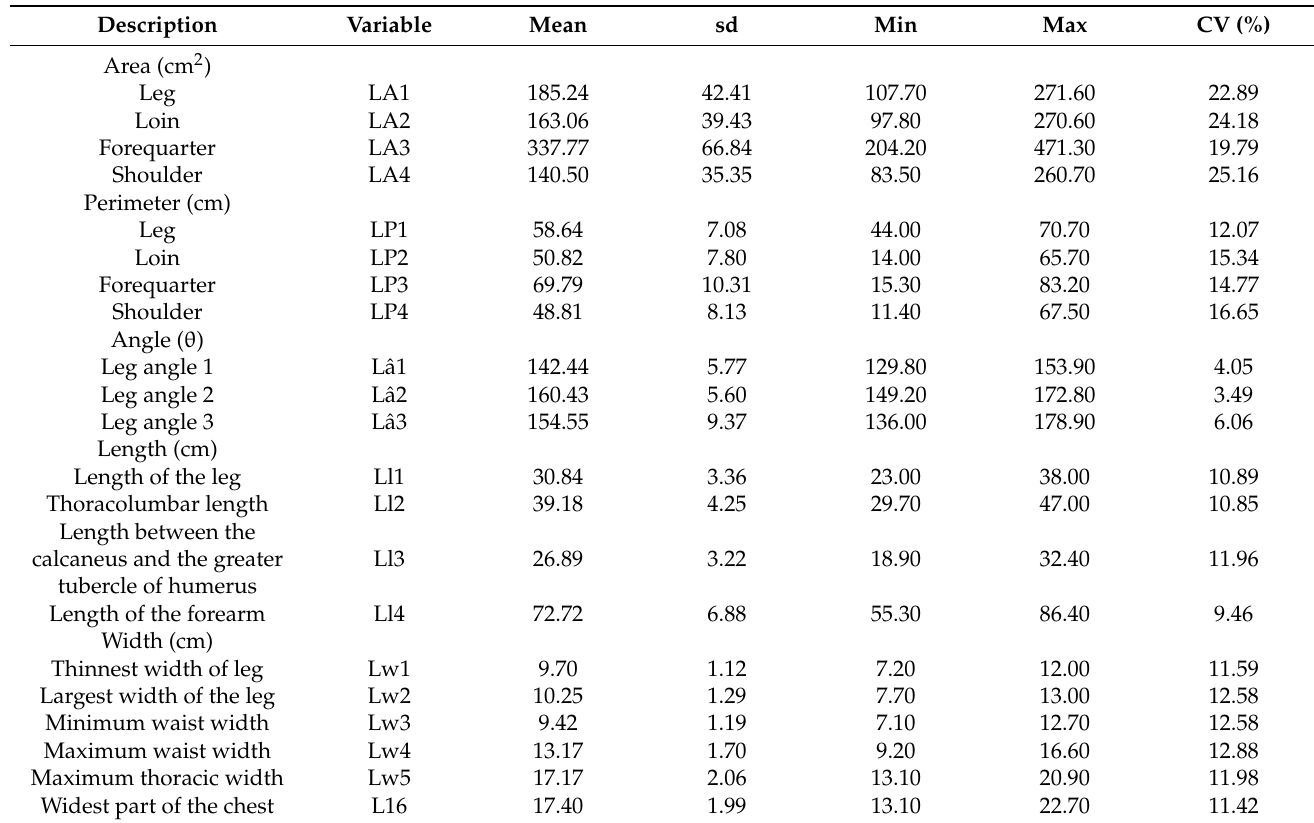
Table 2. Mean, standard deviation (sd), minimum (min), maximum (max) and coefficient of variation (CV) of the video image analysis (VIA)